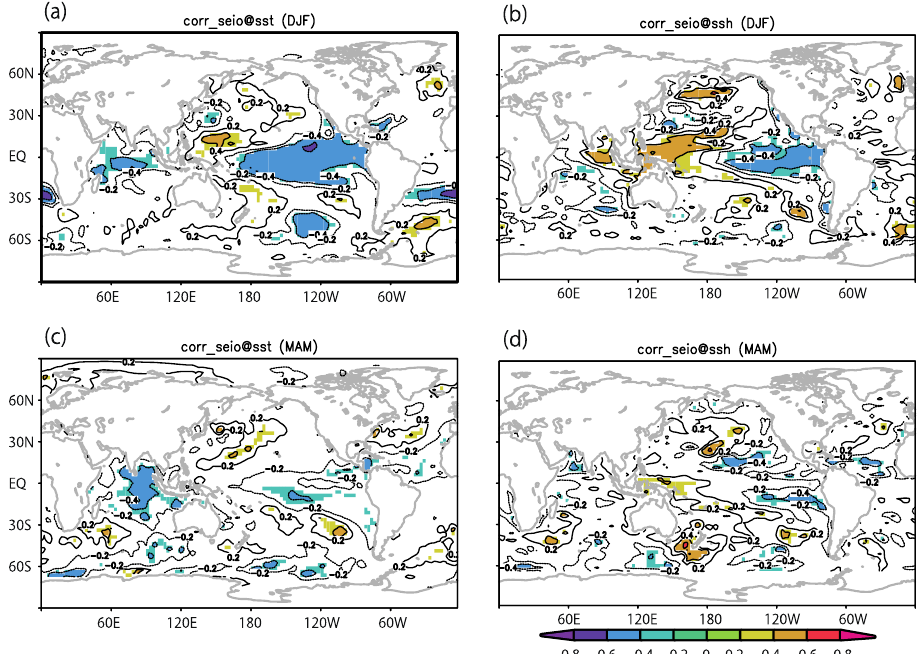
Figure 3. Same as Figure 2 but for the TCF anomaly (defined as occurrence in 5° × 5° bins, units are TCs per season) over the SEIO region (averaged over 10 – 30° S, 90 – 120° E). ( a ) DJF SST, ( b ) DJF SSH, ( c ) MAM SST, ( d ) MAM SSH.